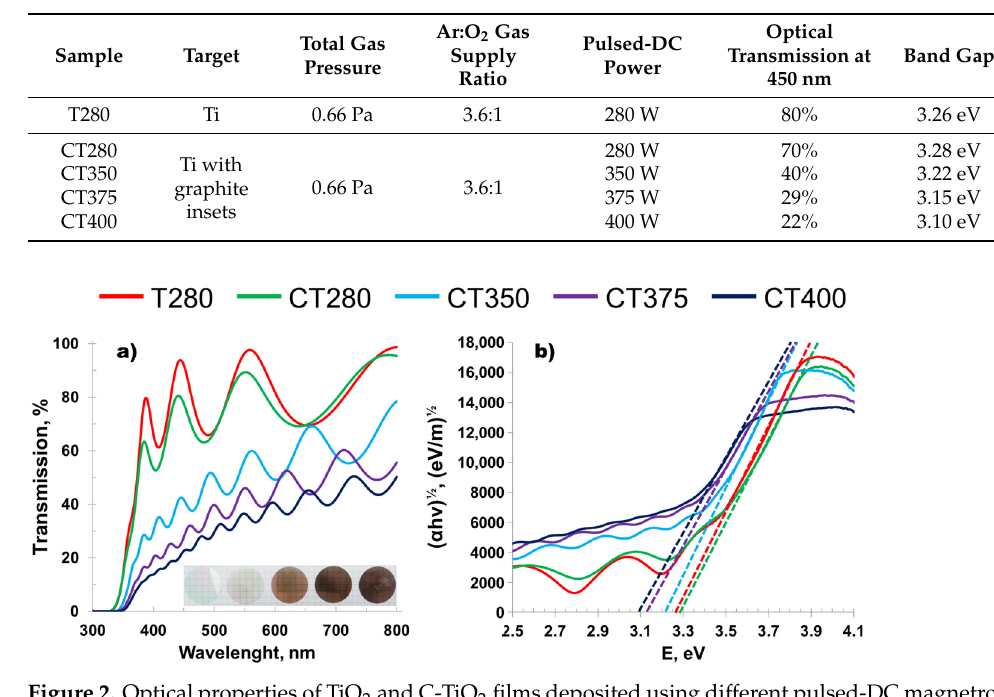
Table 1. Key deposition parameters, optical transmission and band gap values of C-TiO 2 films.